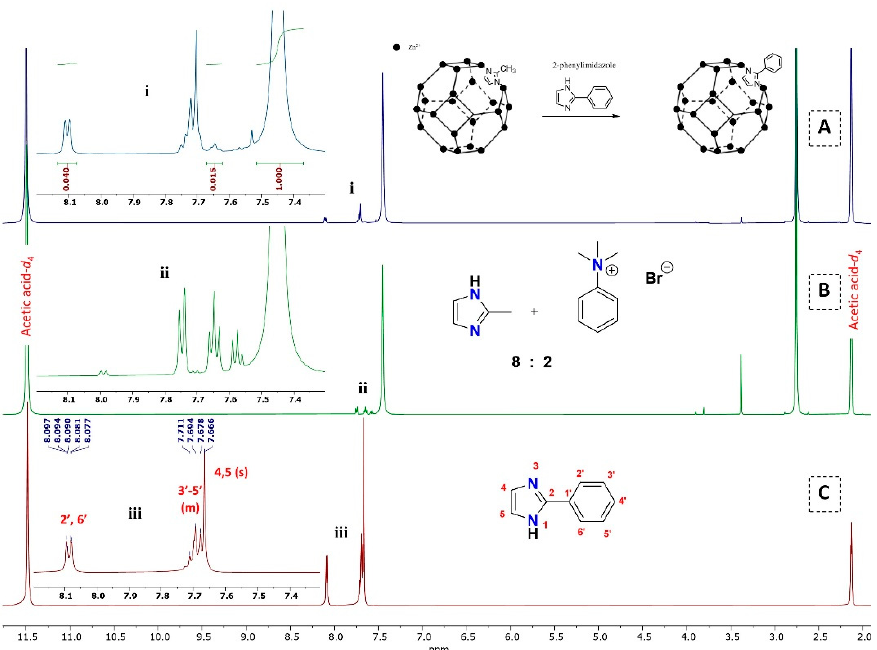
Figure 13. 1 H NMR spectra (in CD 3 COOD) of (A) exchanged ZIF-8 sample by 2-PhIM (1:3), (B) ZIF-8 and (C)